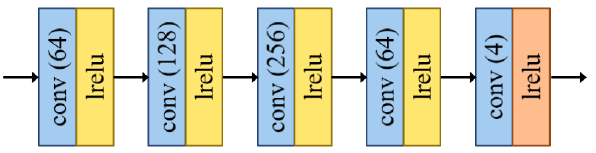
Figure 3. The network architecture of the advanced fusion